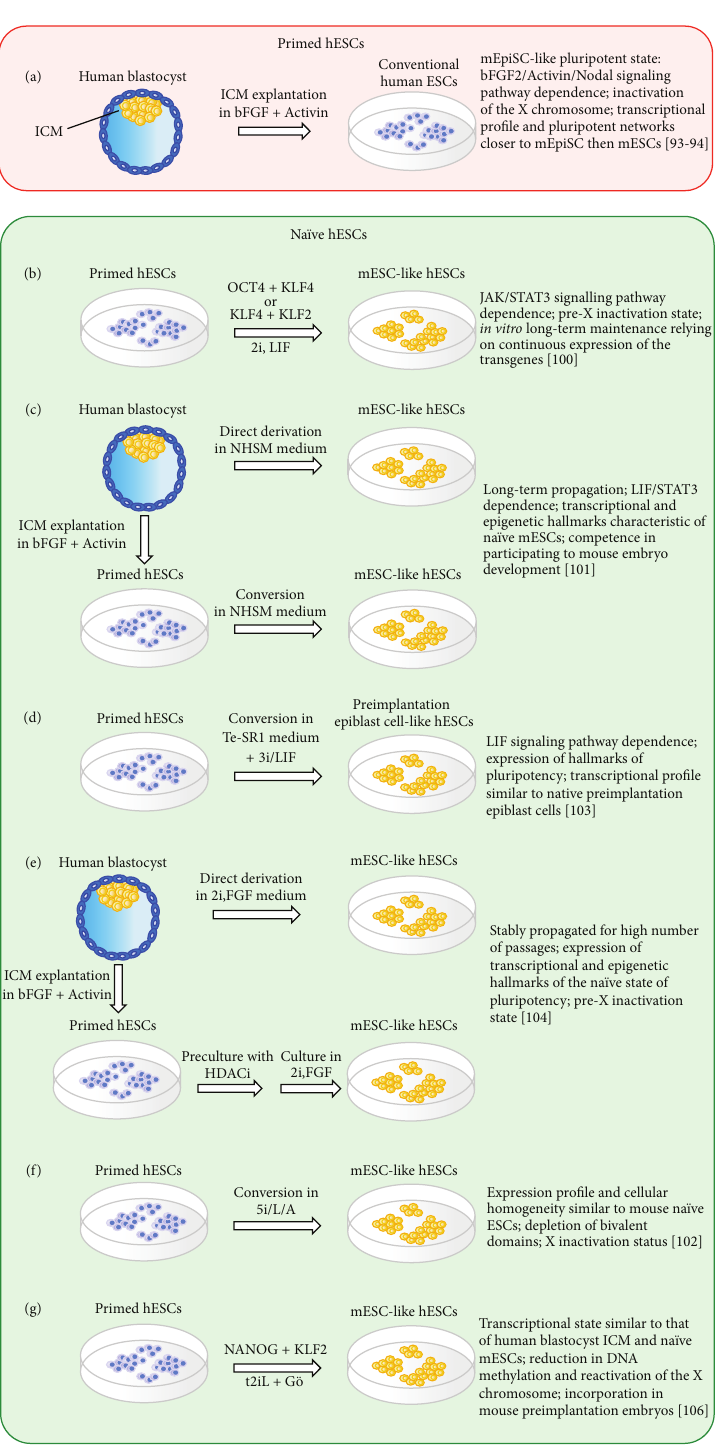
Figure 3: Schematic representation of culture conditions used to obtain primed and na¨ıve pluripotent hESCs. (a) Conventional hESCs are derived from human blastocysts using a culture medium supplemented with bFGF and Activin A. hESCs derived in conventional culture conditions exhibit a pluripotent state more similar to murine EpiSCs than ESCs and are defined as primed hESCs. (b) hESCs with mESC-like characteristics can be produced by induced expression of either OCT4/KLF4 or KLF4/KLF2 transgenes in primed hESCs. Stable in vitro maintenance of these na¨ıve hESCs requires continuous expression of the transgenes. (c, d, and e) Defined conditions allowing derivation of na¨ıve hESCs from either already established primed hESCs or directly from blastocysts without the use of pluripotency-associated transgenes. (f) Conversion of primed hESCs into na¨ıve state using five kinase inhibitors (5i) + LIF + Activin. (g) Short term expression of NANOG and KLF2 in primed hESC cells is sufficient to trigger ground state in hESCs cultivated in 2iL medium plus PKC inhibitor G ¨